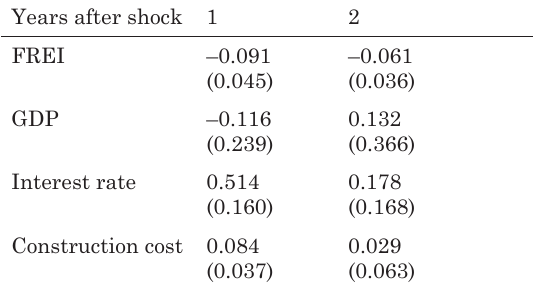
Table 5. responses to a house price shock years after shock 1